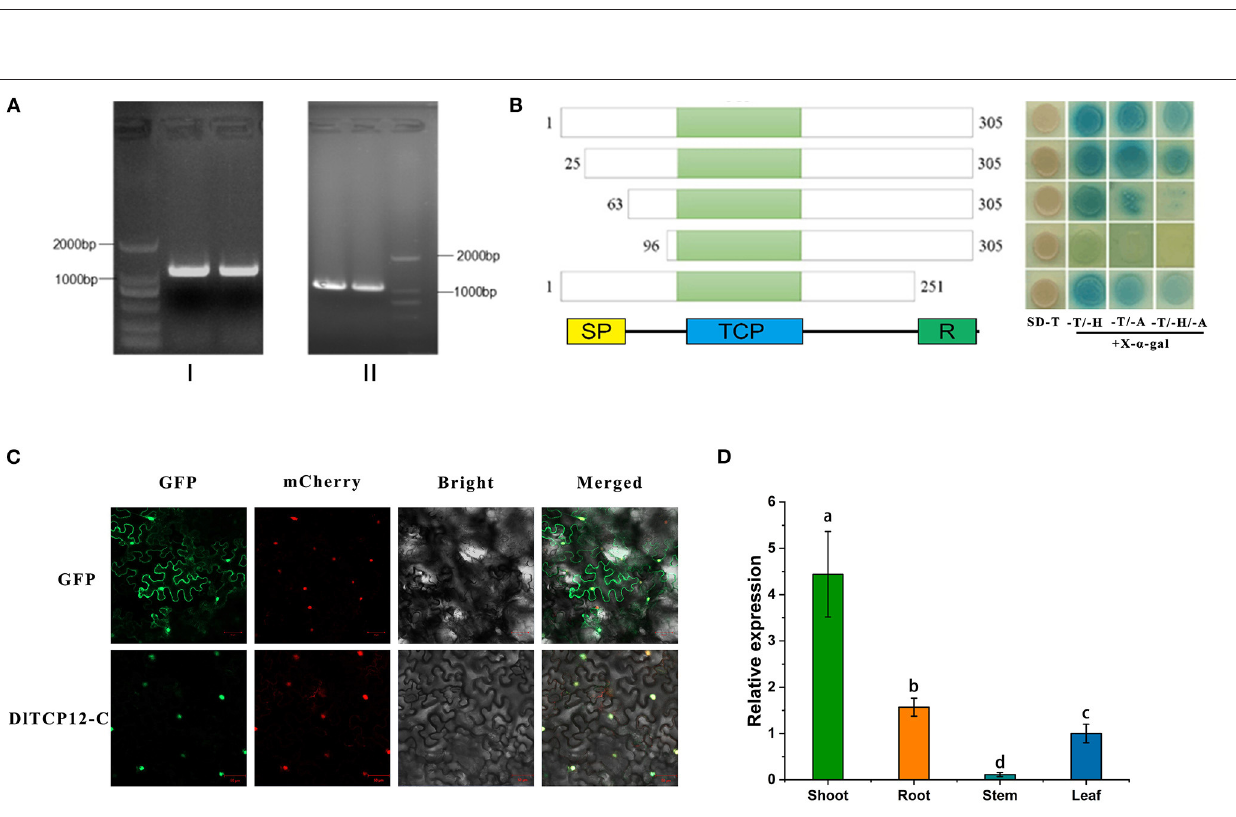
FIGURE 11 | Gene structure, transactivational analyses, subcellular localization, and expression patterns of the DlTCP12-C . (A) Using genomic DNA (I) and cDNA (II) as template, gel electrophoresis amplification results of DlTCP12-C . (B) Transcriptional self-activation experiments of five truncated forms of DlTCP12-C, SD-T, -T/-H, -T/-A, and -T/-H/-A represents SD medium lacking Trp, Trp and His, Trp and Ade, Trp, and His and Ade, respectively. (C) Subcellular localization of DlTCP12-C protein. (D) The expression levels of DlTCP12-C in bamboo shoot, root, stem, and leaf; those with different marked letters were represented significantly different: p < 0.05.